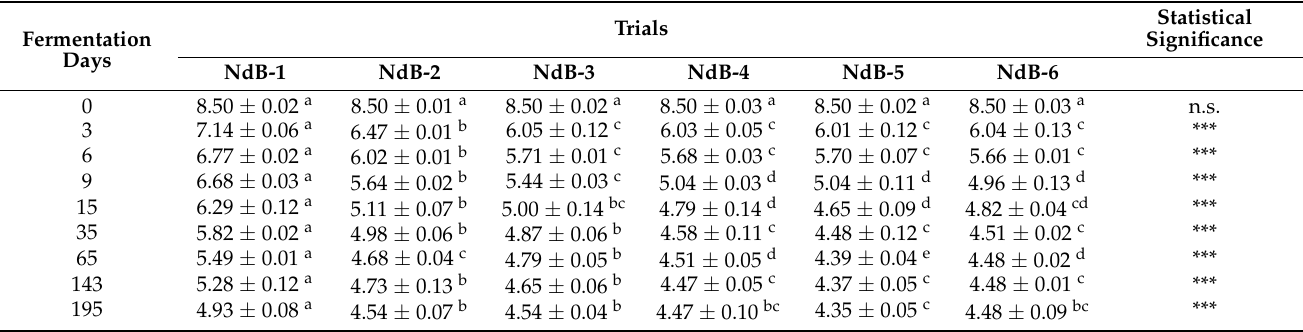
Table 2. pH values measured during fermentation of Nocellara del Belice table